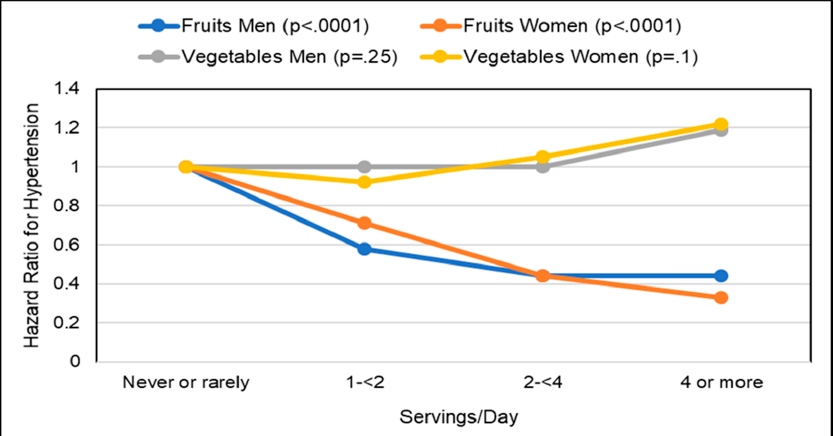
Figure 12. Association between the number of fruit or vegetable servings and hypertension risk in a cohort of middle-aged and older Koreans [182].